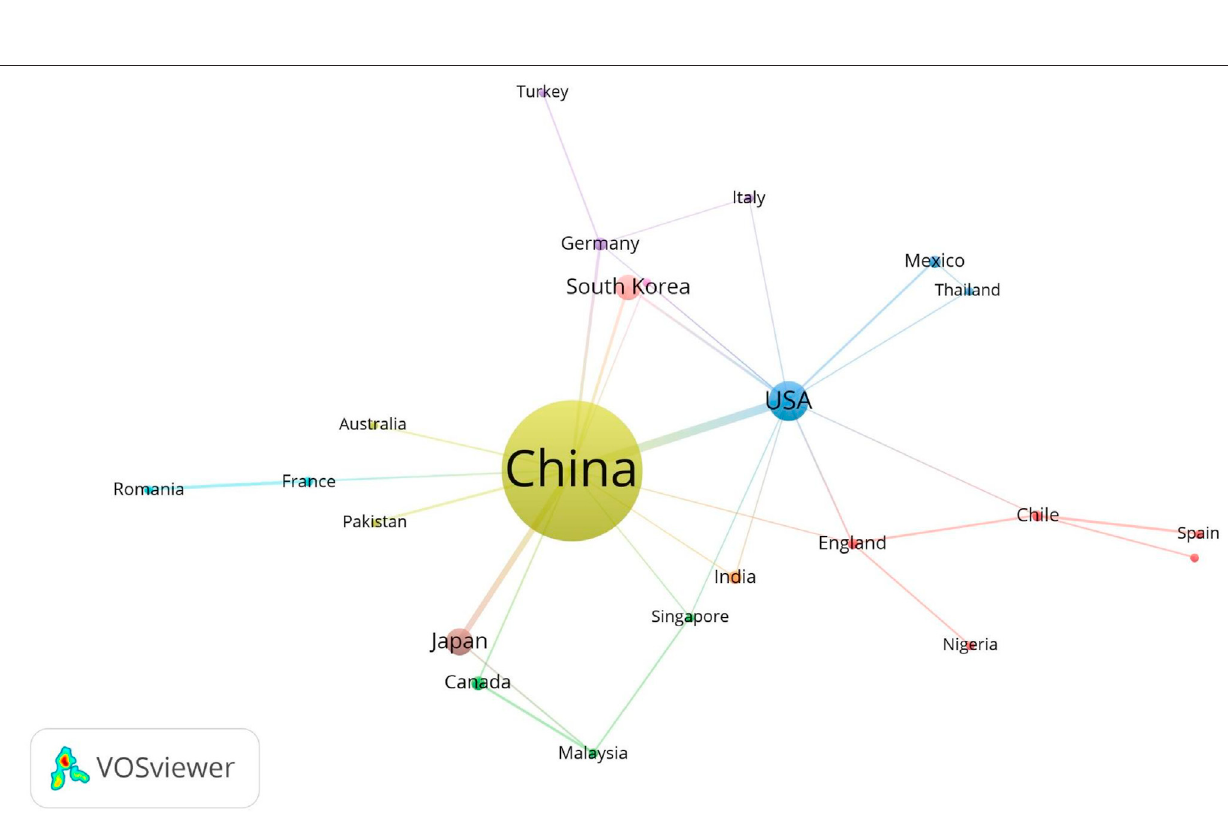
Frontiers in Pharmacology |